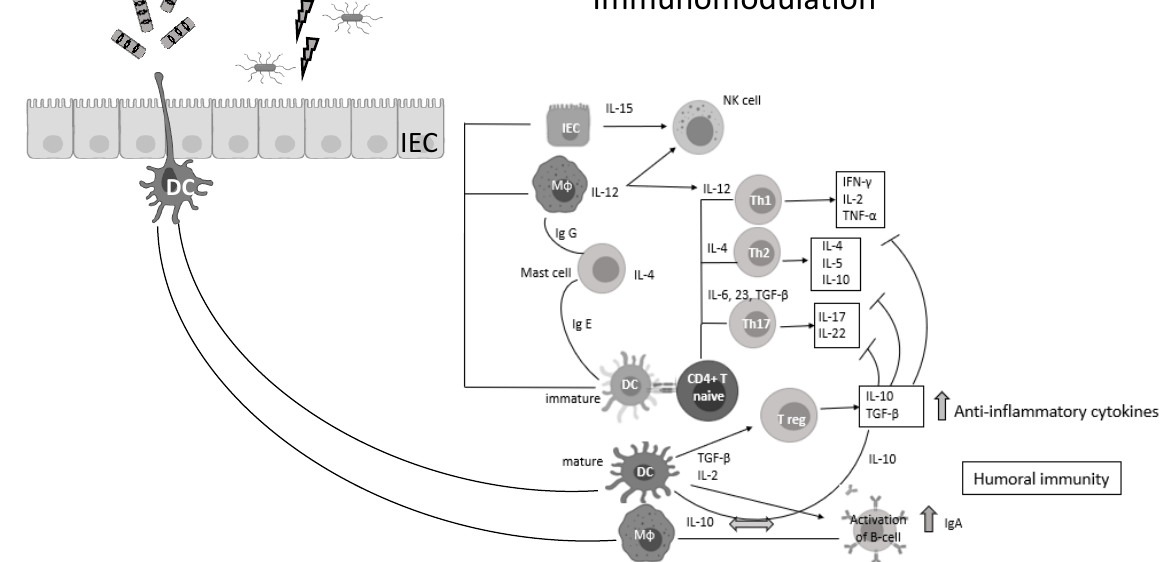
Figure 1. Probiotic bacteria can modulate cytokine release, thus influencing both innate and adaptive immune response. Part of this figure was created with BioRender (https://biorender.com, accessed on 2 October).